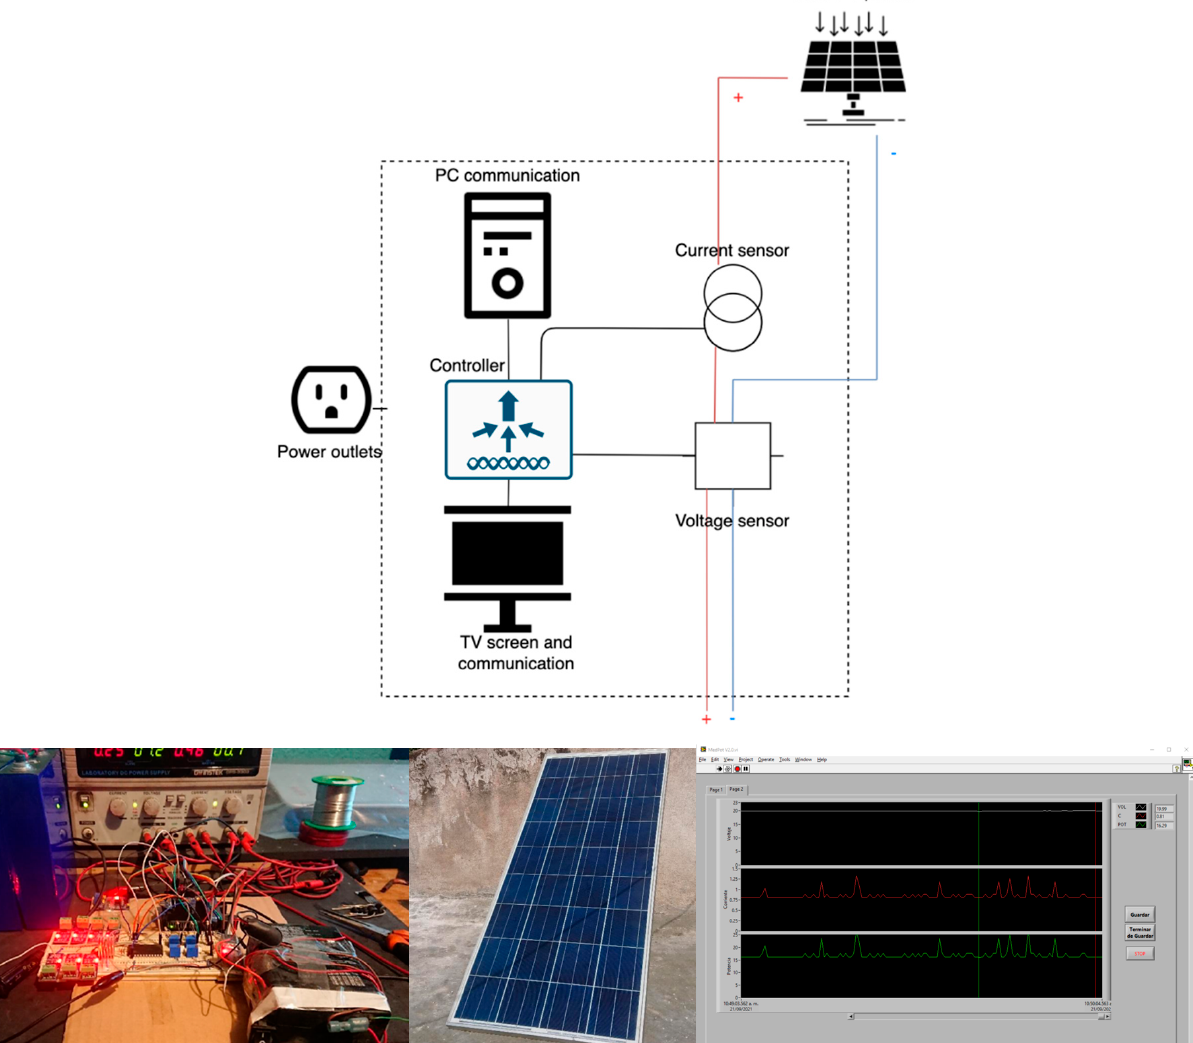
Figure 5. Diagram ( top ) and first implementation of the proposed system: electronic design, PV panel and LabView controller ( bottom ).